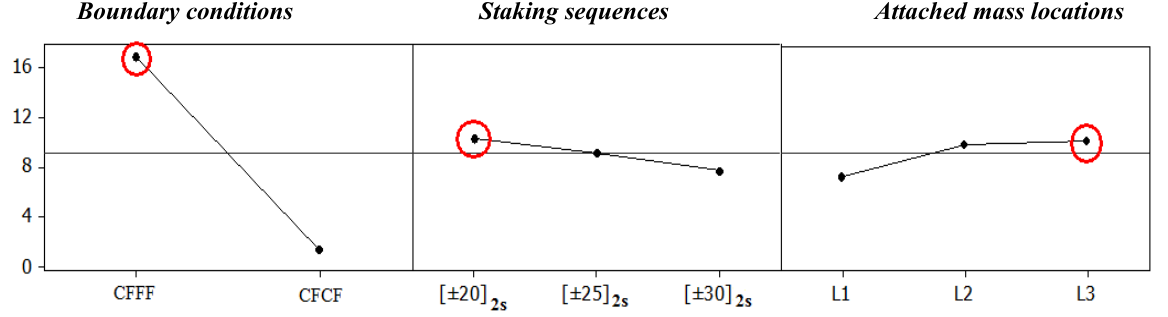
Figure 9. Plot of main effects based on Means and S/N ratios for damping